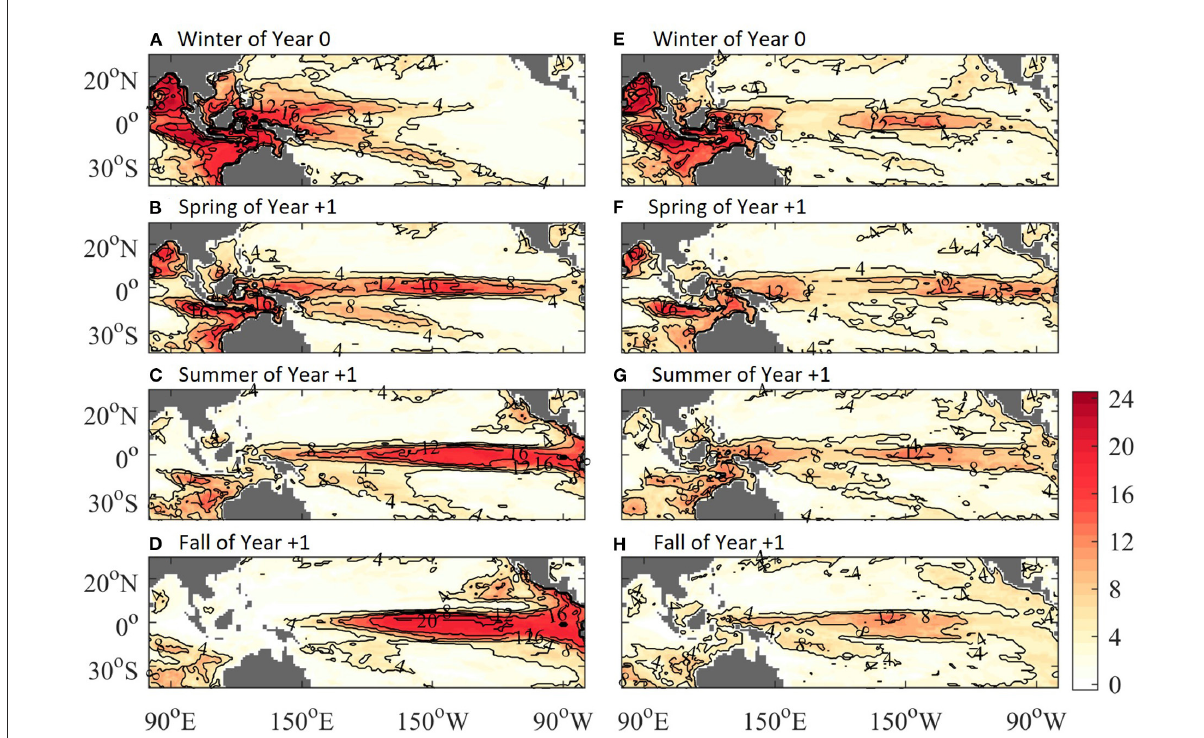
FIGURE6 Numbers of CMIP5 models with significant positive correlations between the STIO SSHA in fall and the tropical Indo-Pacific Oceans SSHA in (A) winter of Year + 0, (B) spring of Year + 1, (C) summer of Year + 1, and (D) fall of Year + 1. (E–H) are same as (A–D) , but with the ENSO signal